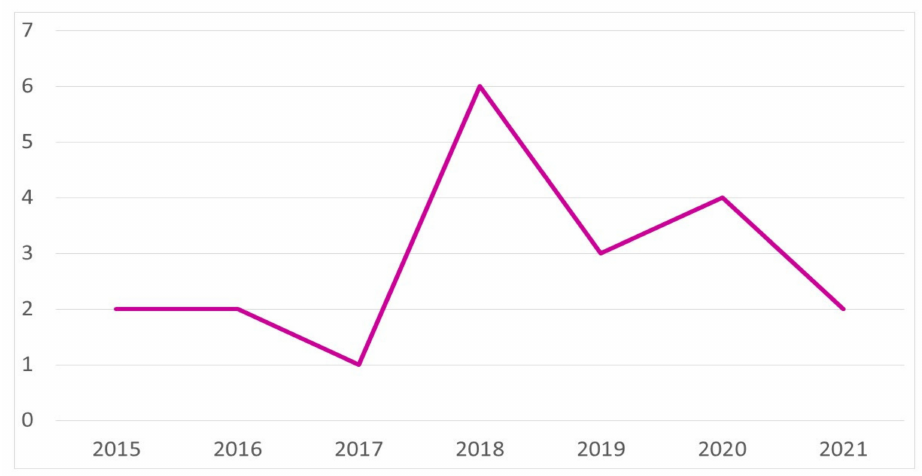
Figure 2. Years of publications of the selected